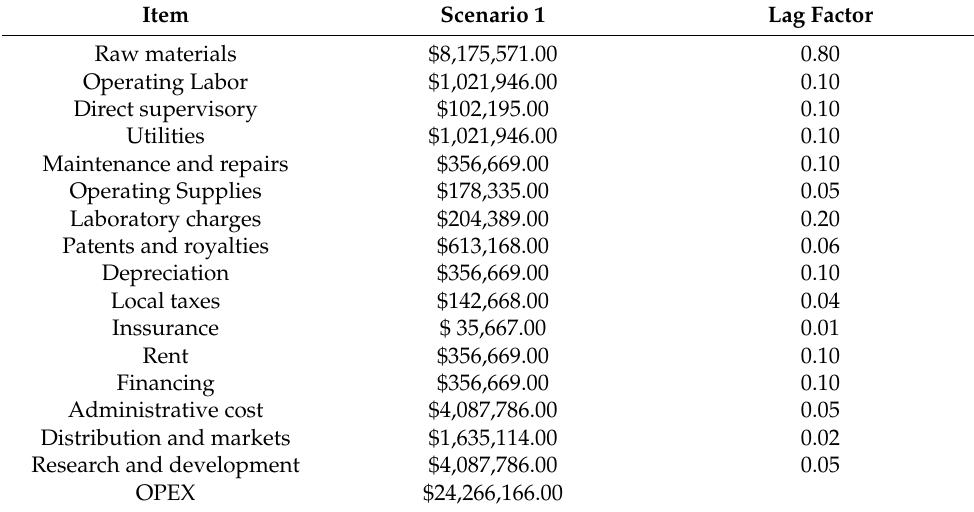
Table 6. Operational expenses for Scenario 1 and Scenario 2.